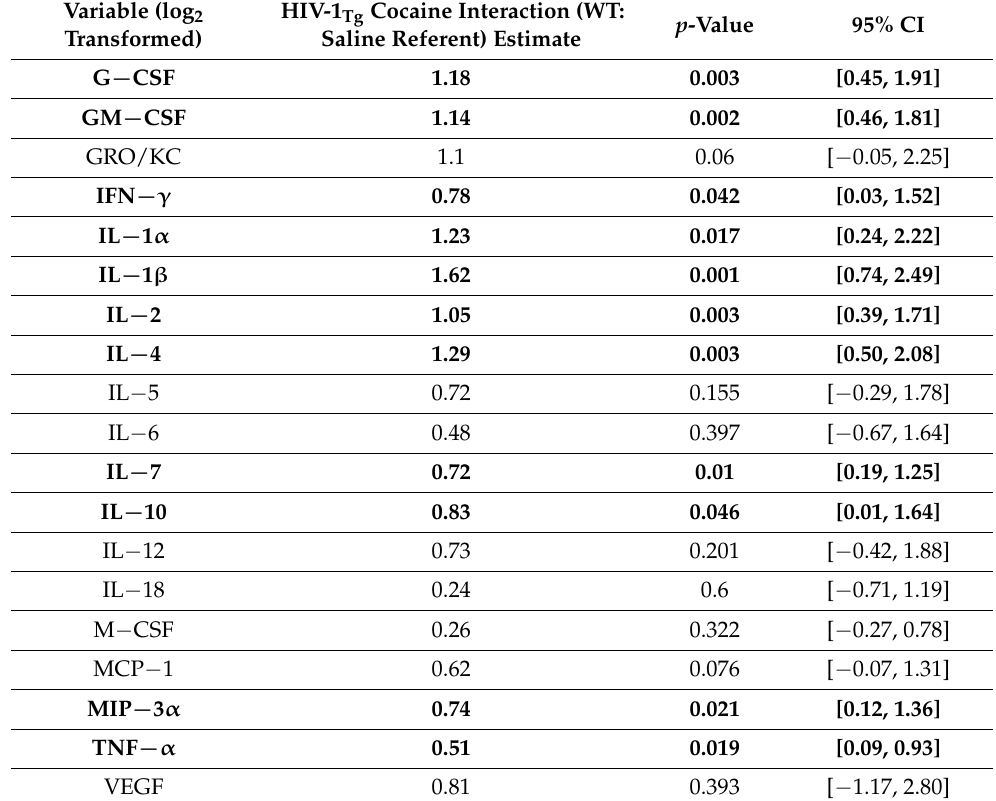
Table 2. Linear regression results for frontal cortex (fCTX) cytokine, chemokine, or growth factor levels with interaction effect. Linear regression analysis was performed to evaluate main